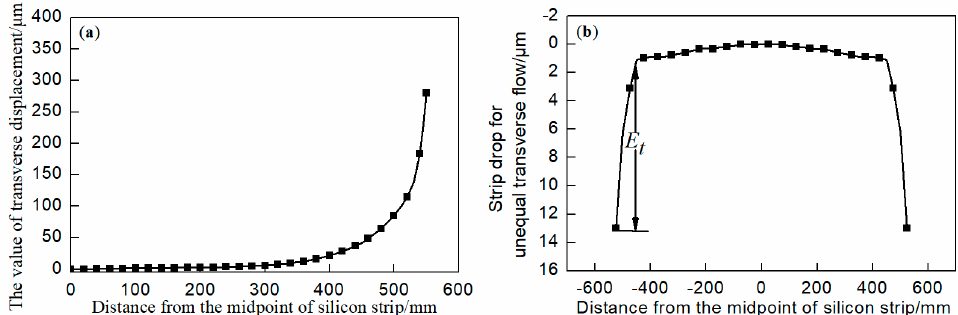
Figure 8. The edge drop for the unequal transverse flow of the metal: ( a ) Value of transverse displacement at any point of the metal; and ( b ) finite element calculation results.